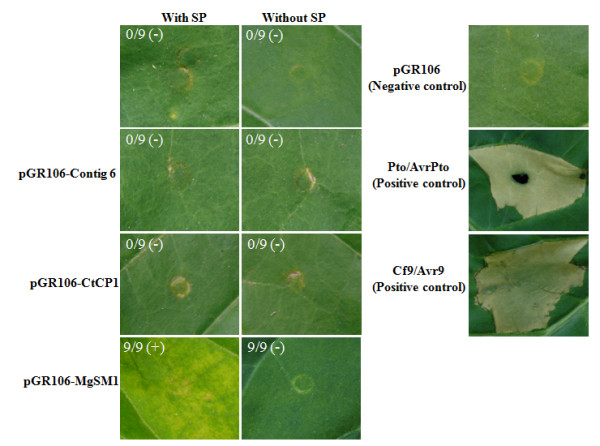
In plantaexpression of Contigs 6, 32, CtCP1 and MgSM1. In planta expression of Contigs 6, 32, CtCP1 and MgSM1 (A) N. tobacum leaves were challenged by agro-infiltration of A. tumefaciens strains expressing pGR106-contig 321-142 (SP), pGR106-contig 3216-142 (-SP), pGR106-contig 61-139 (SP), pGR106-contig 616-139 (-SP), pGR106-CtCP11-138 (SP), pGR106-CtCP122-138 (-SP), pGR106-MgSM11-137 (SP) and pGR106-MgSM122-137 (-SP). Empty vector pGR106 and matching pairs of R/Avr (Pto/AvrPto and Cf9/Avr9) were used as negative and positive controls, respectively. Pictures were taken 7 days after infiltration. SP, Signal peptide.